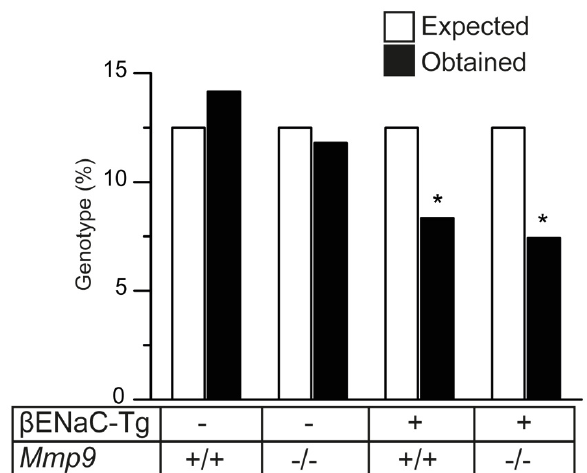
Figure 2. Genetic deletion of Mmp9 does not reduce mortality in β ENaC ‐ Tg mice. Effects of genetic deletion of Mmp9 on survival were determined by comparing the genotype frequencies expected from the Mendelian ratios with the observed genotype frequencies in 6 ‐ week ‐ old WT, Mmp9 ‐ / ‐ , β ENaC ‐ Tg and β ENaC ‐ Tg/ Mmp9 ‐ / ‐ mice. * p < 0.05 compared to WT, n = 46–136 mice per genotype group. Statistical analysis was performed with chi ‐ square test.